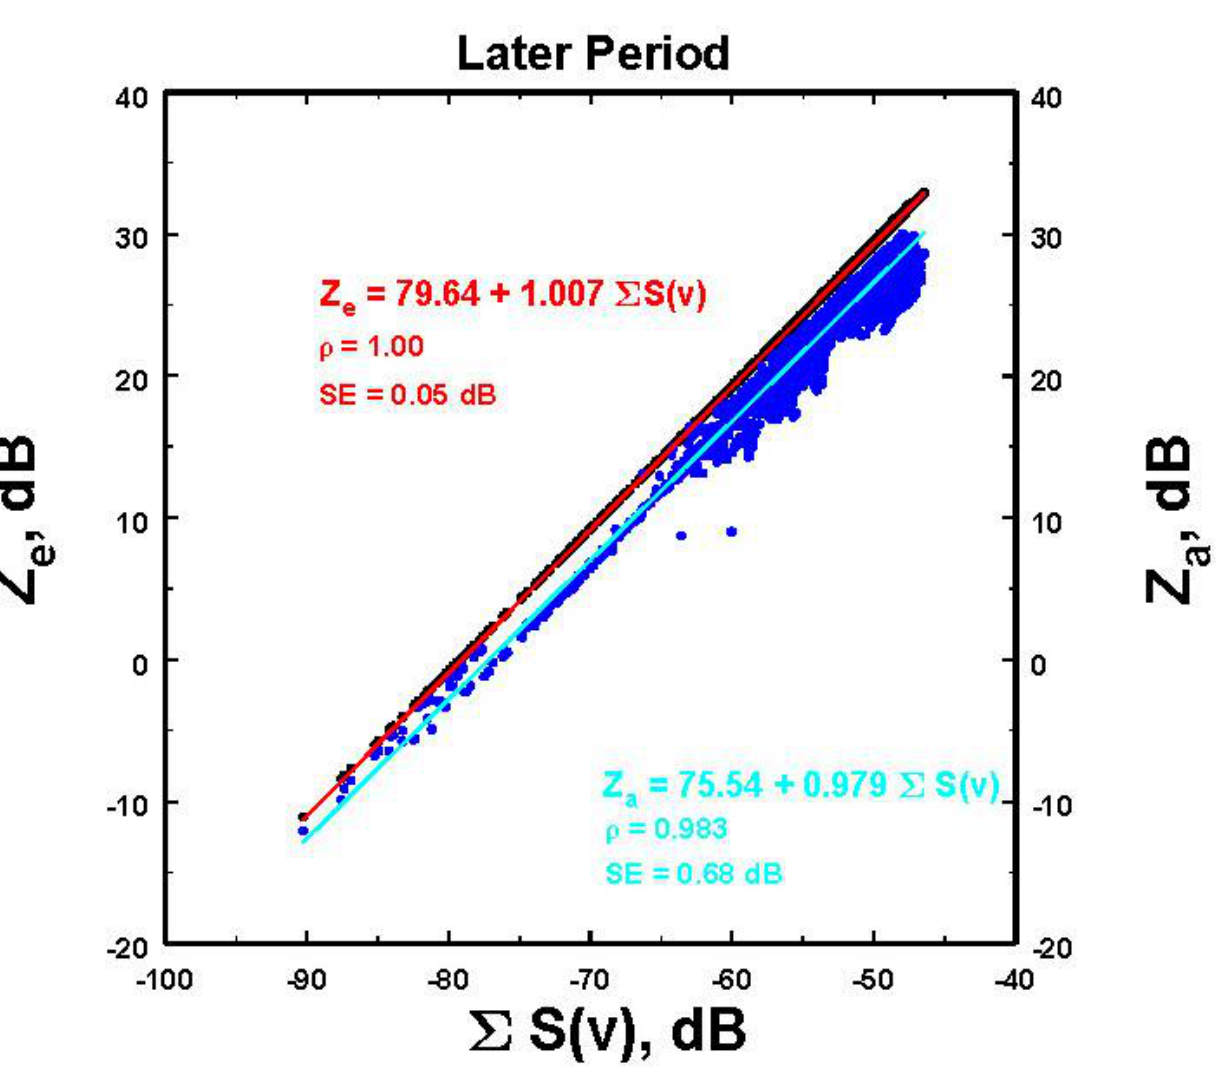
Figure A3. As in Figure A1, linear fits of the logarithms of the MRR-reported equivalent radar reflectivities, Ze, and the attenuated reflectivities vs. the logarithms of the summations over the reported Doppler spectral powers but for the later period. SE is the standard error of the fits.